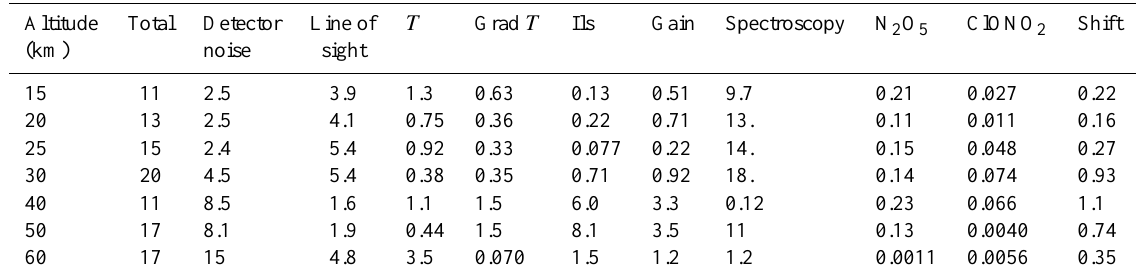
Table 4. Error budget for CH 4 for the measurement of in orbit 10324 at 46.0 ◦ N, 144.5 ◦ W on 20 February 2004, 07:48:31UTC (derived from full-resolution spectra, version V5H_CH4_21). Relative values are given as percentages. Altitude Total Detector Line of